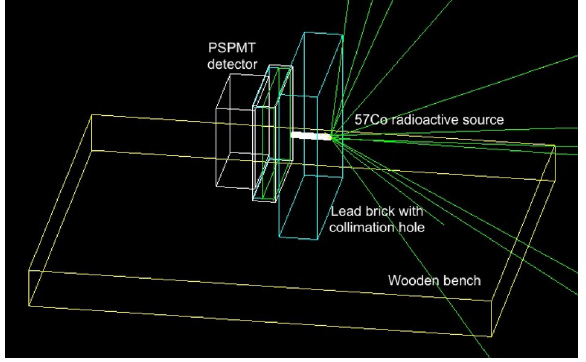
Fig. 5. Geometry of GEANT4 simulation for crystal calibration with lead brick collimator with 57 Co source.